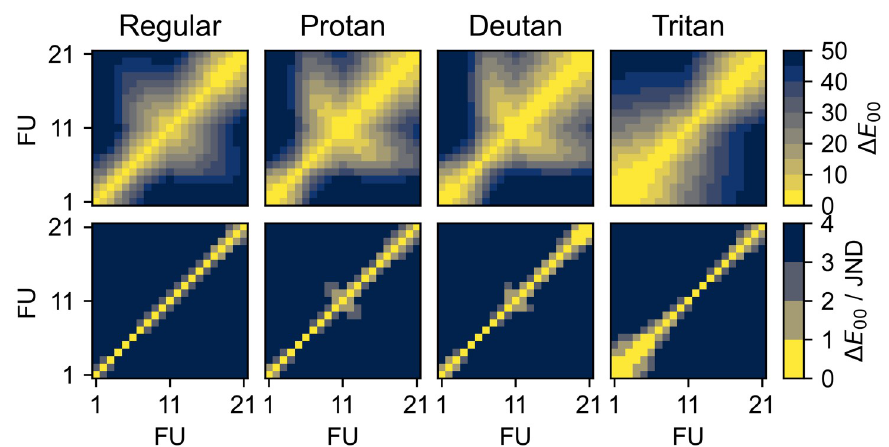
Fig 4. Confusion matrices for regular and deficient colour vision. The top panels show the full range of Δ E 00 , while the bottom panels have a narrower colour bar, in units of just-noticeable difference (JND, Δ E 00 = 2.3). Even with regular vision, some pairs of FU colours are difficult to distinguish ( Δ E 00 � 3 JND) Protan and deutan primarily decrease the discriminability of the middle (green) and high (brown) colours, while tritan primarily affects the low (blue) colours, as expected.